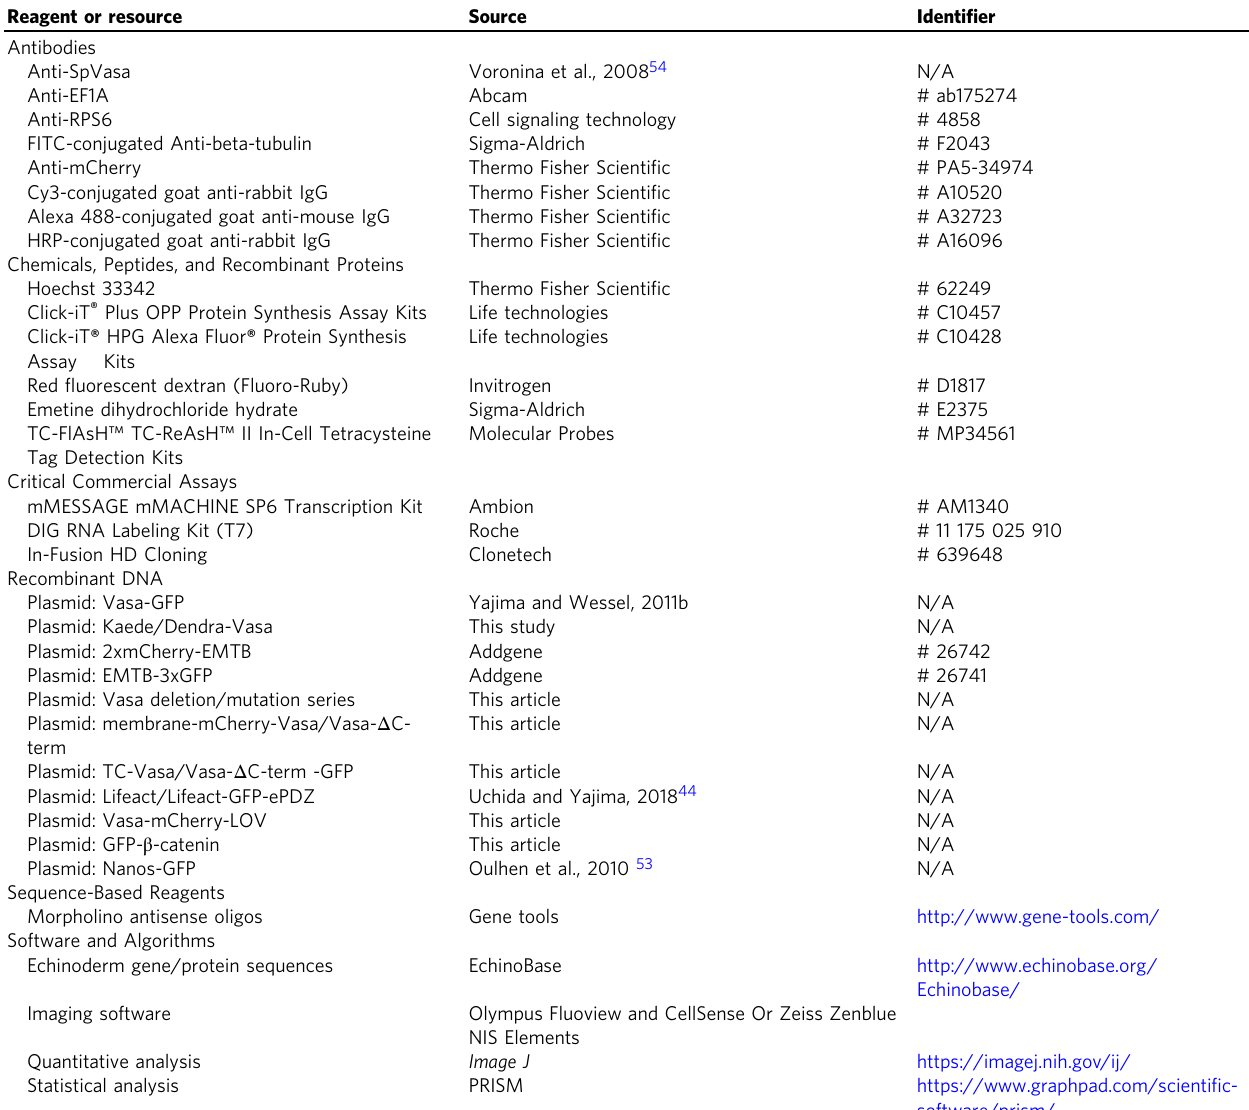
Table 1 A list of all materials used in this